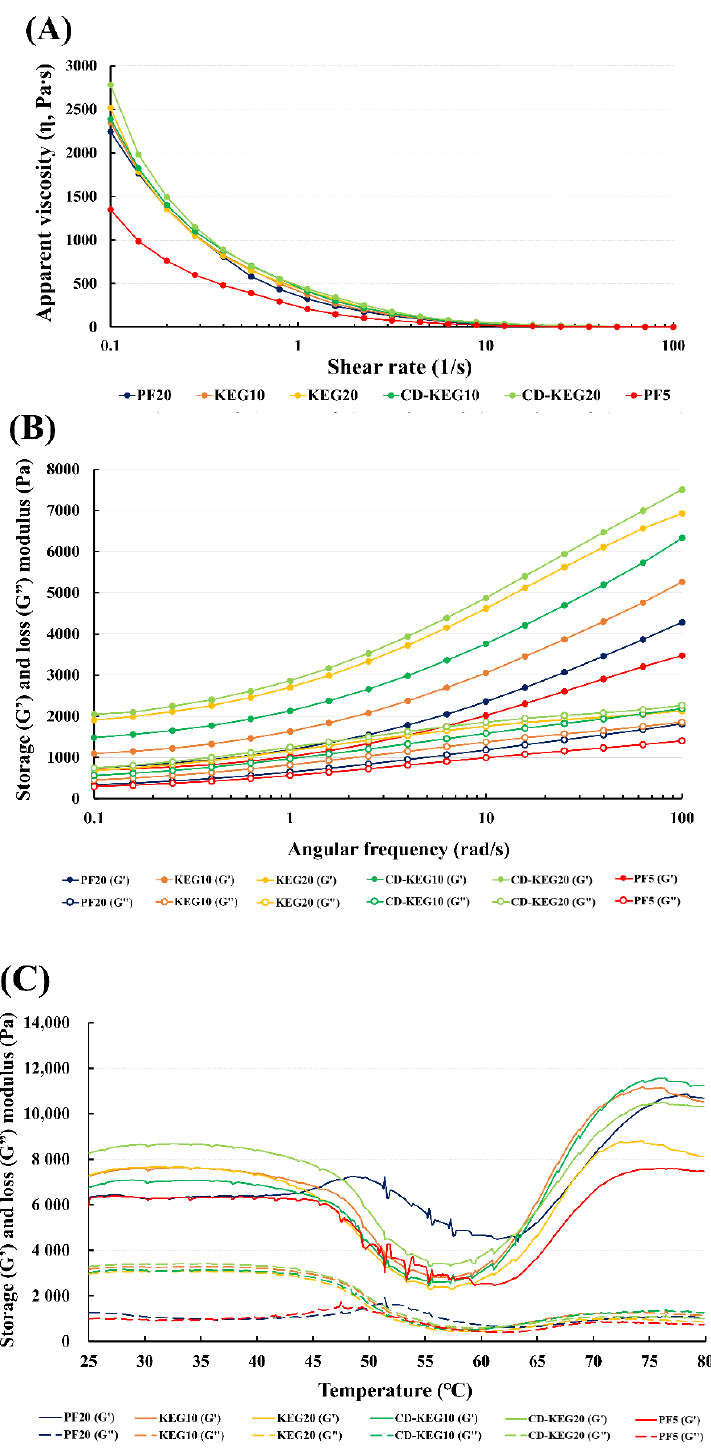
Figure 3. Rheological properties of emulsion gel-supplemented meat batter. ( A ) Apparent viscosity at 10 ◦ C, ( B ) viscoelasticity as a function of frequency in the range of 0.1–100 rad/s at 10 ◦ C, and ( C ) viscoelasticity during temperature sweep at 25–80 ◦ C, 1 Hz, and 0.5% strain. Each colored line represents the rheological properties of the gel-supplemented sausages ( n = 3). Navy, PF20 (20% pork backfat); orange, KEG10 (10% pork backfat + 10% konjac-based emulsion gel); yellow, KEG20 (20% konjac-based emulsion gel), green, CD-KEG10 (10% pork backfat + 10% cyclodextrin (CD)-supplemented konjac-based emulsion gel); light green, CD-KEG20 (20% CD-supplemented konjac-based emulsion gel); red, PF5 (5% pork